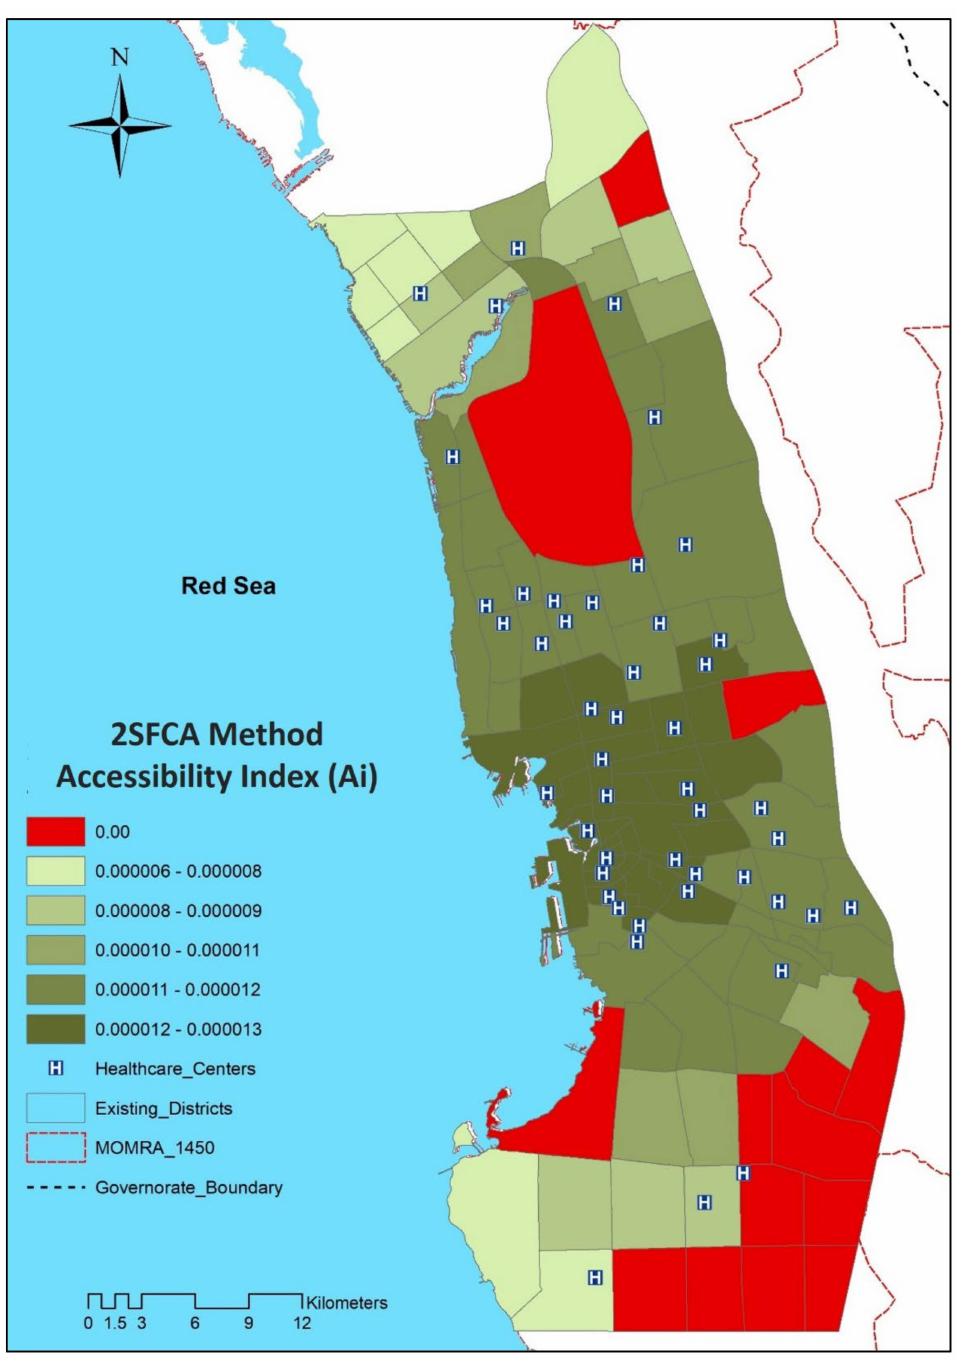
Figure 4. Results of spatial accessibility score of healthcare centers using 2SFCA method at the districts level within the ArcGIS